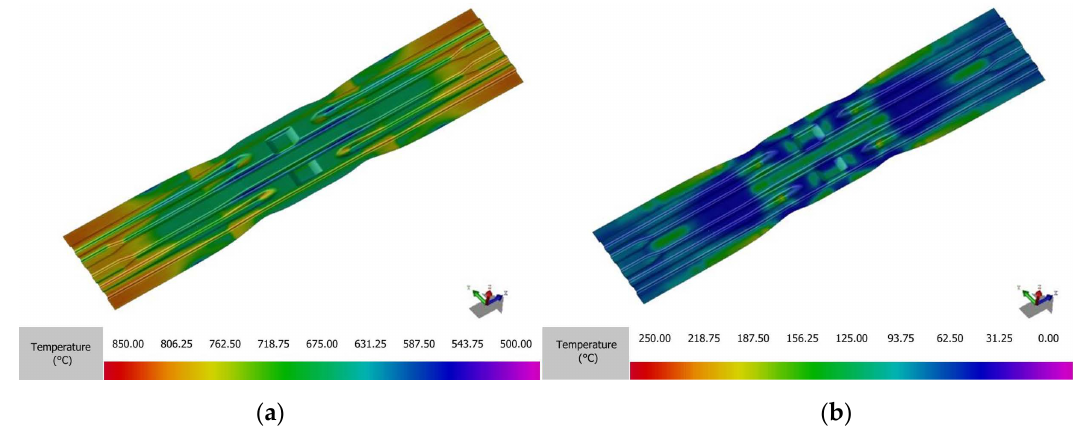
Figure 7. Temperature distribution of the blank before ( a ) and after quenching stage ( b ).